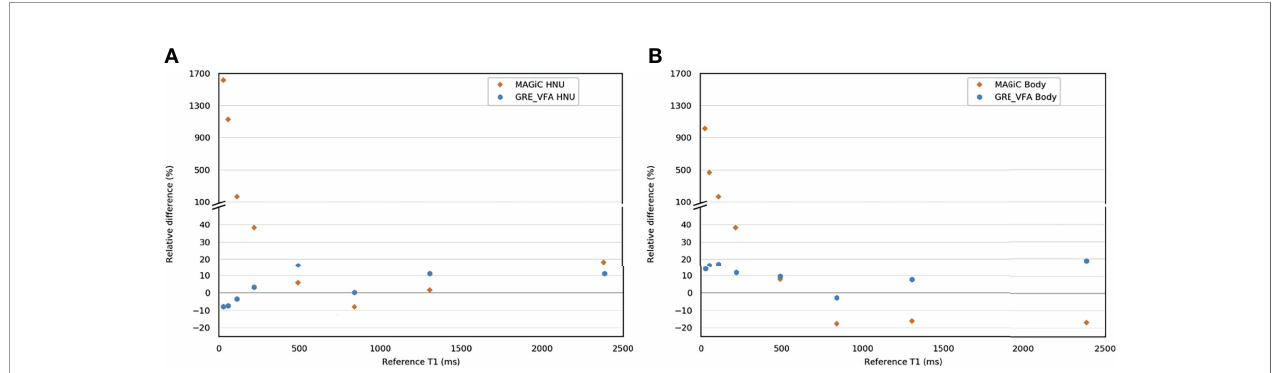
FIGURE 2 | Bland – Altman graph representing the relative difference (in percent) between the T 1 measurement with the MAGIC ® and the gradient echo with variable fl ip angle (GRE-VFA) sequences for the head and neck unit (HNU) coil (A) and the BODY coil (B) compared to the reference